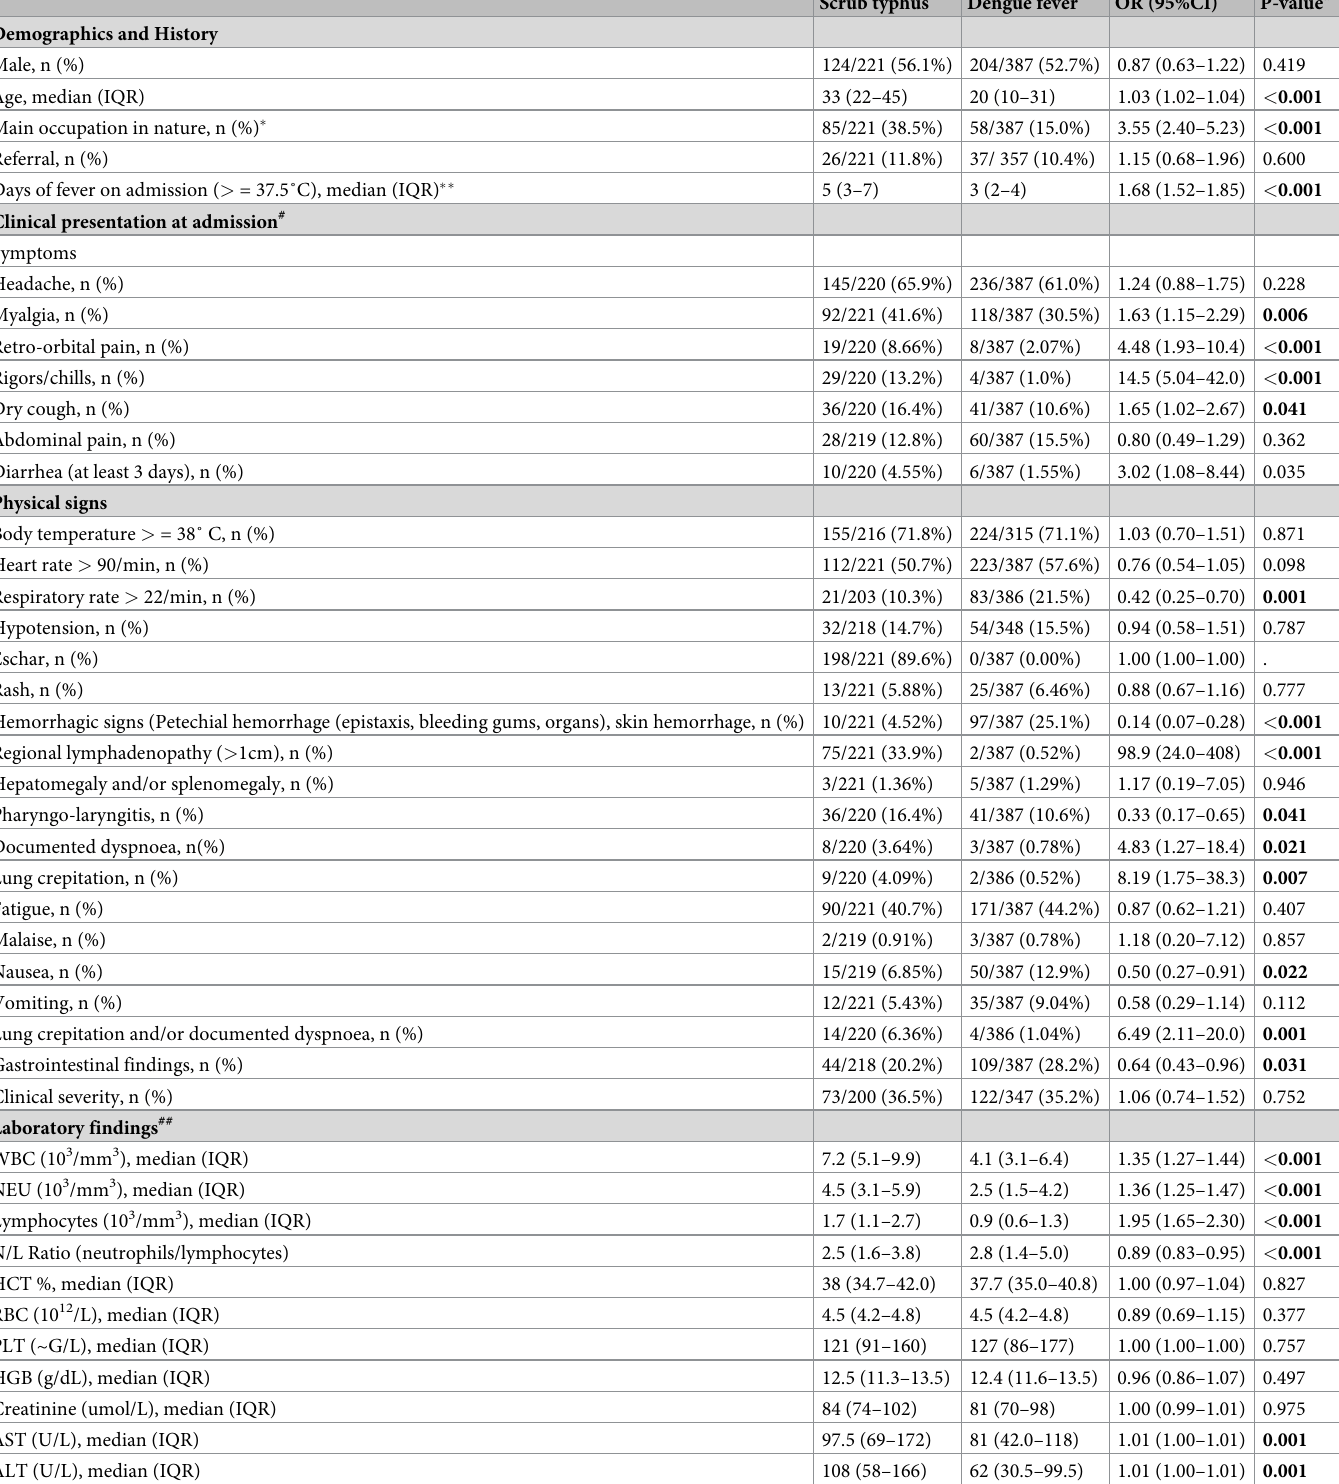
Table 1. Demographic, clinical, diagnostic and laboratory characteristics of patients at